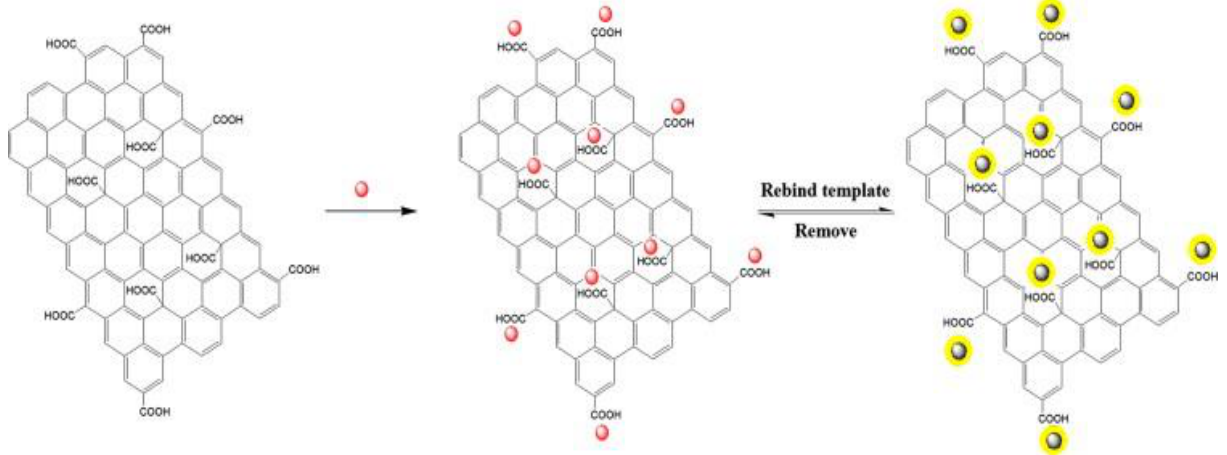
Figure 11. Representation of the synthesis of GO/QDs@molecular imprinted polymers (MIP) by a one-pot room temperature synthesis strategy with reverse microemulsion polymerization. Taken from Liu et al. [200].